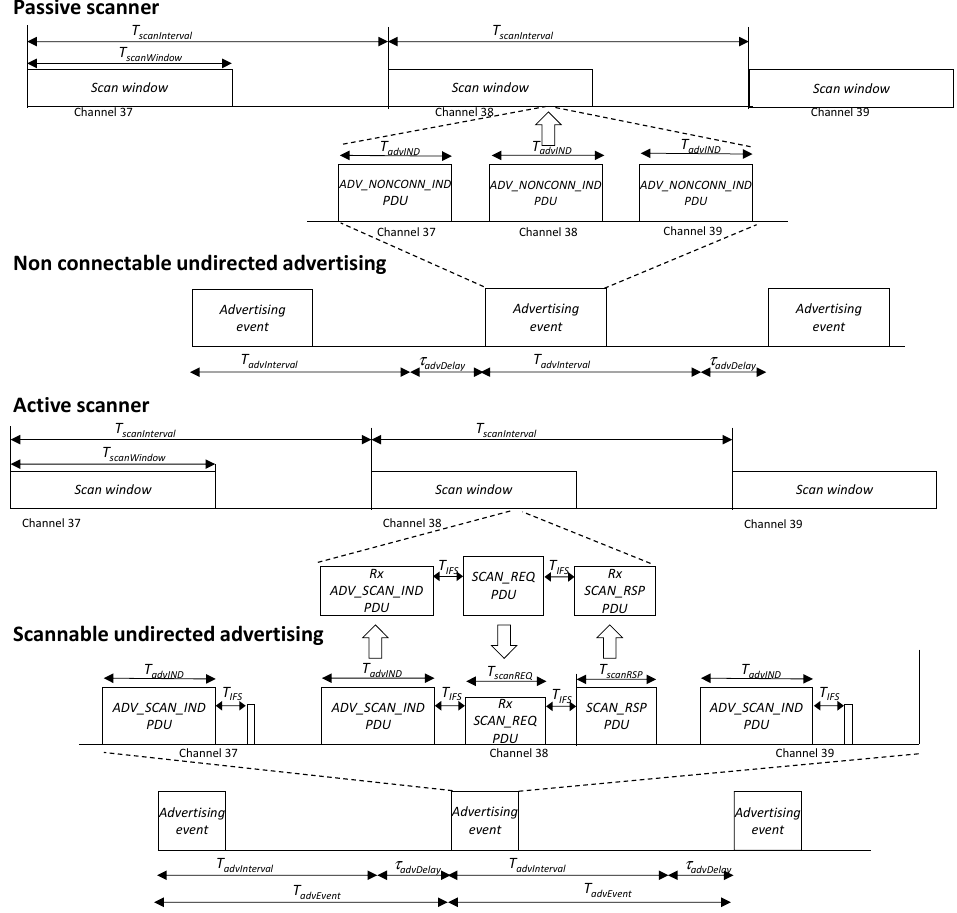
Figure 3. Non-connectable and scannable undirected advertisement detection procedure.